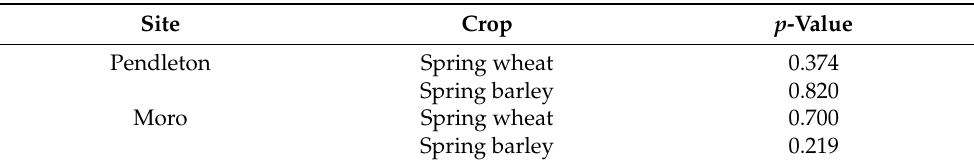
Table 3. Comparison of crop yield with and without Russian thistle pressure for each location and crop in 2019. Site Crop p -Value Pendleton Spring wheat 0.374 Spring barley 0.820 Moro Spring wheat 0.700 Spring barley